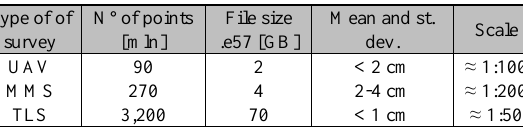
Table 13. Characteristics of the results derived from three different type of